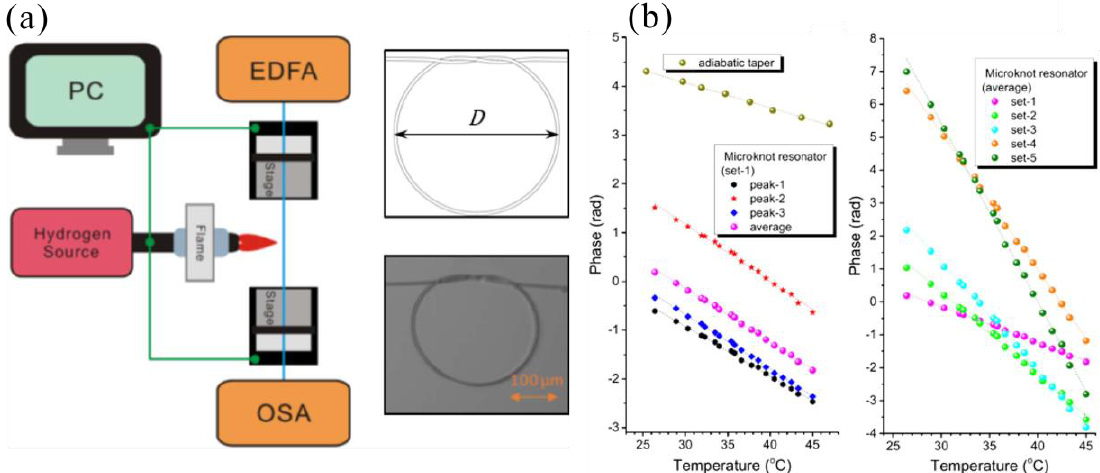
Figure 10. ( a ) Microscopic image of the microfiber knot and schematic setup of the temperature sensor; ( b ) Phase shifts of the fast Fourier transform (FFT) spectrum peaks as a function of temperature [154].